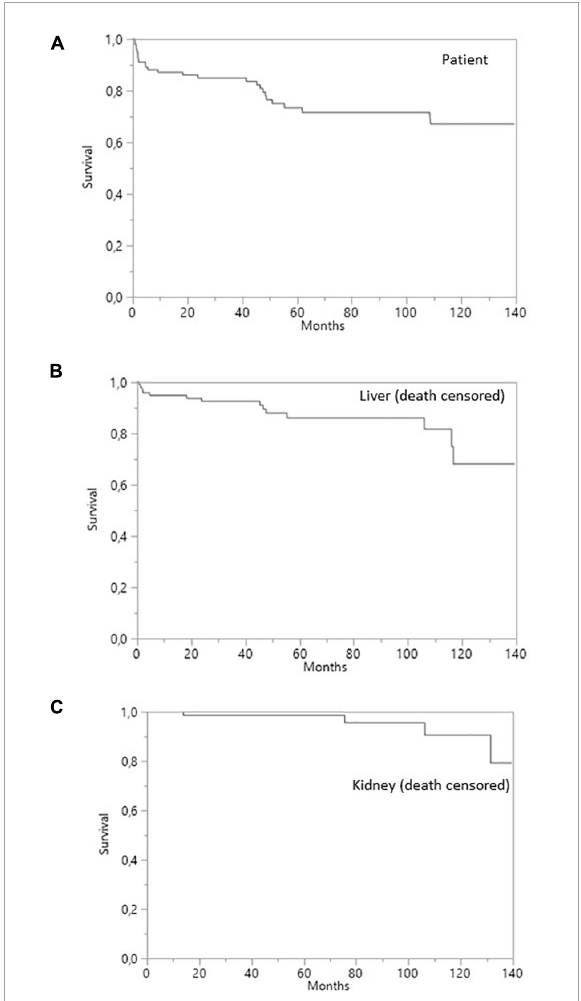
FIGURE1 Survival curves for SLKT patients. (A) Patient survival. (B) Liver survival (death-censored). (C) Kidney survival (death-censored). of the recipient, highest pDSA, MELD score, serum creatinine